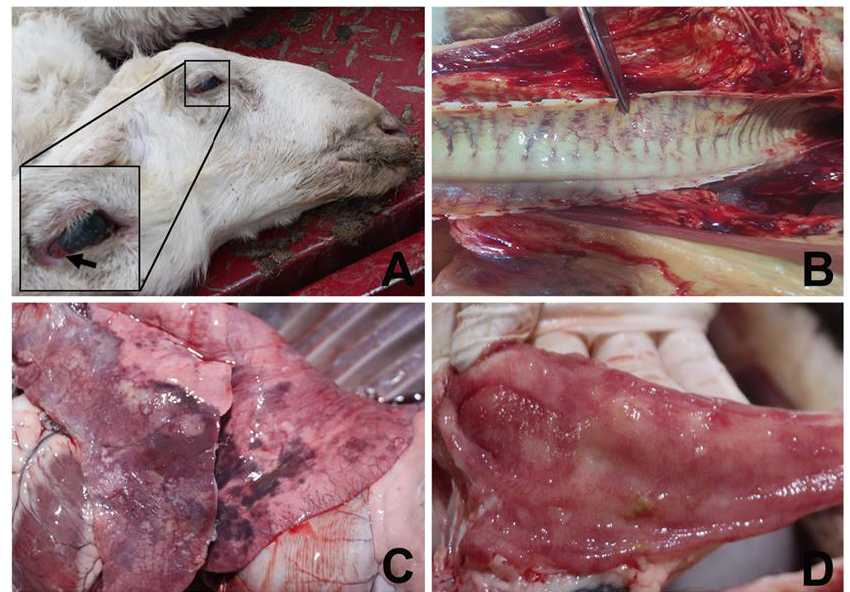
Figure 1. Macroscopic appearance of dead sheep, trachea, lung, and mesentery. ( A ) Congestion of the conjunctiva and nasal discharge were observed in dead sheep; ( B ) Congestive tracheal ring; ( C ) Pulmonary consolidation and congestion; ( D ) Intestinal mucosal hemorrhage.